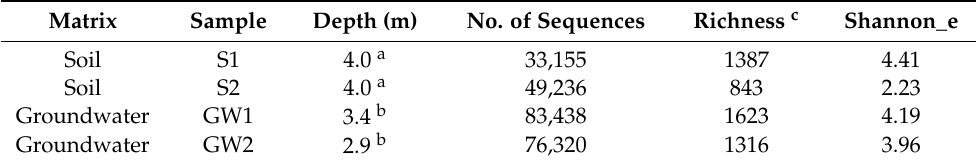
Table 3. Sequencing results and α diversity indices of the soil and groundwater